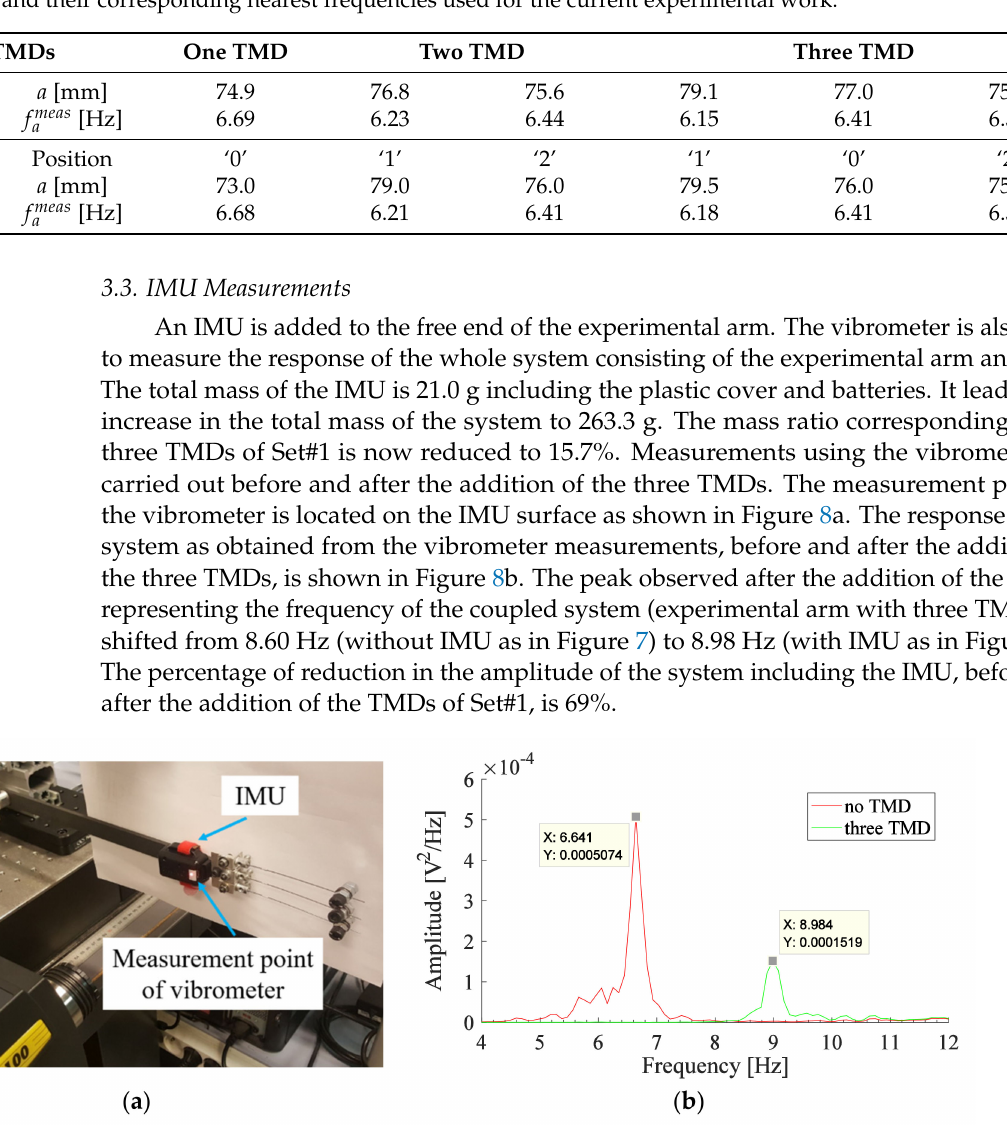
Figure 8. ( a ) IMU added to the end of the experimental arm; ( b ) PSD obtained from vibrometer measurement for the system with three TMDs